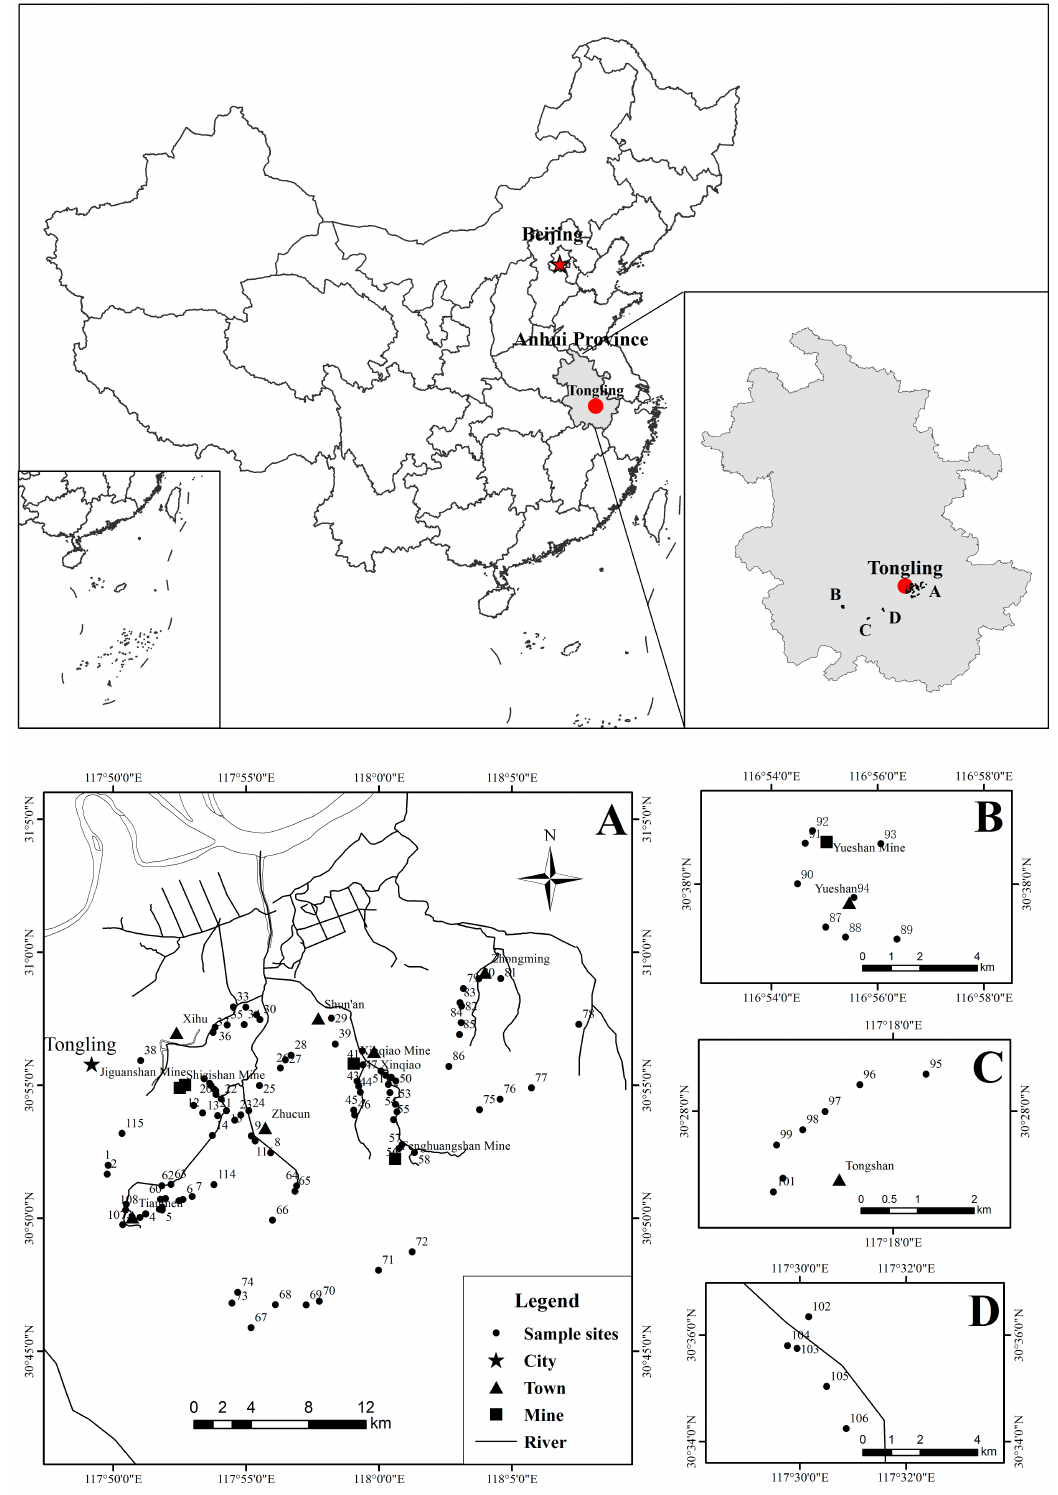
Figure 1. Location map of sample collection in the study area. (A) Concentrated areas of mining;